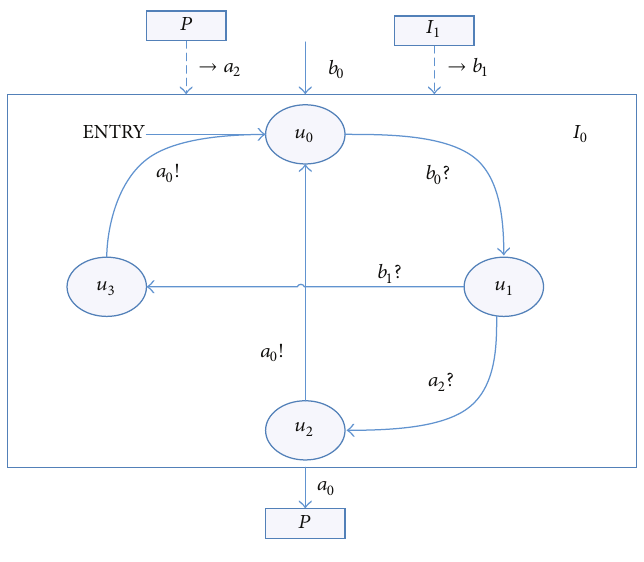
Figure 3: Input automata 𝐼 0